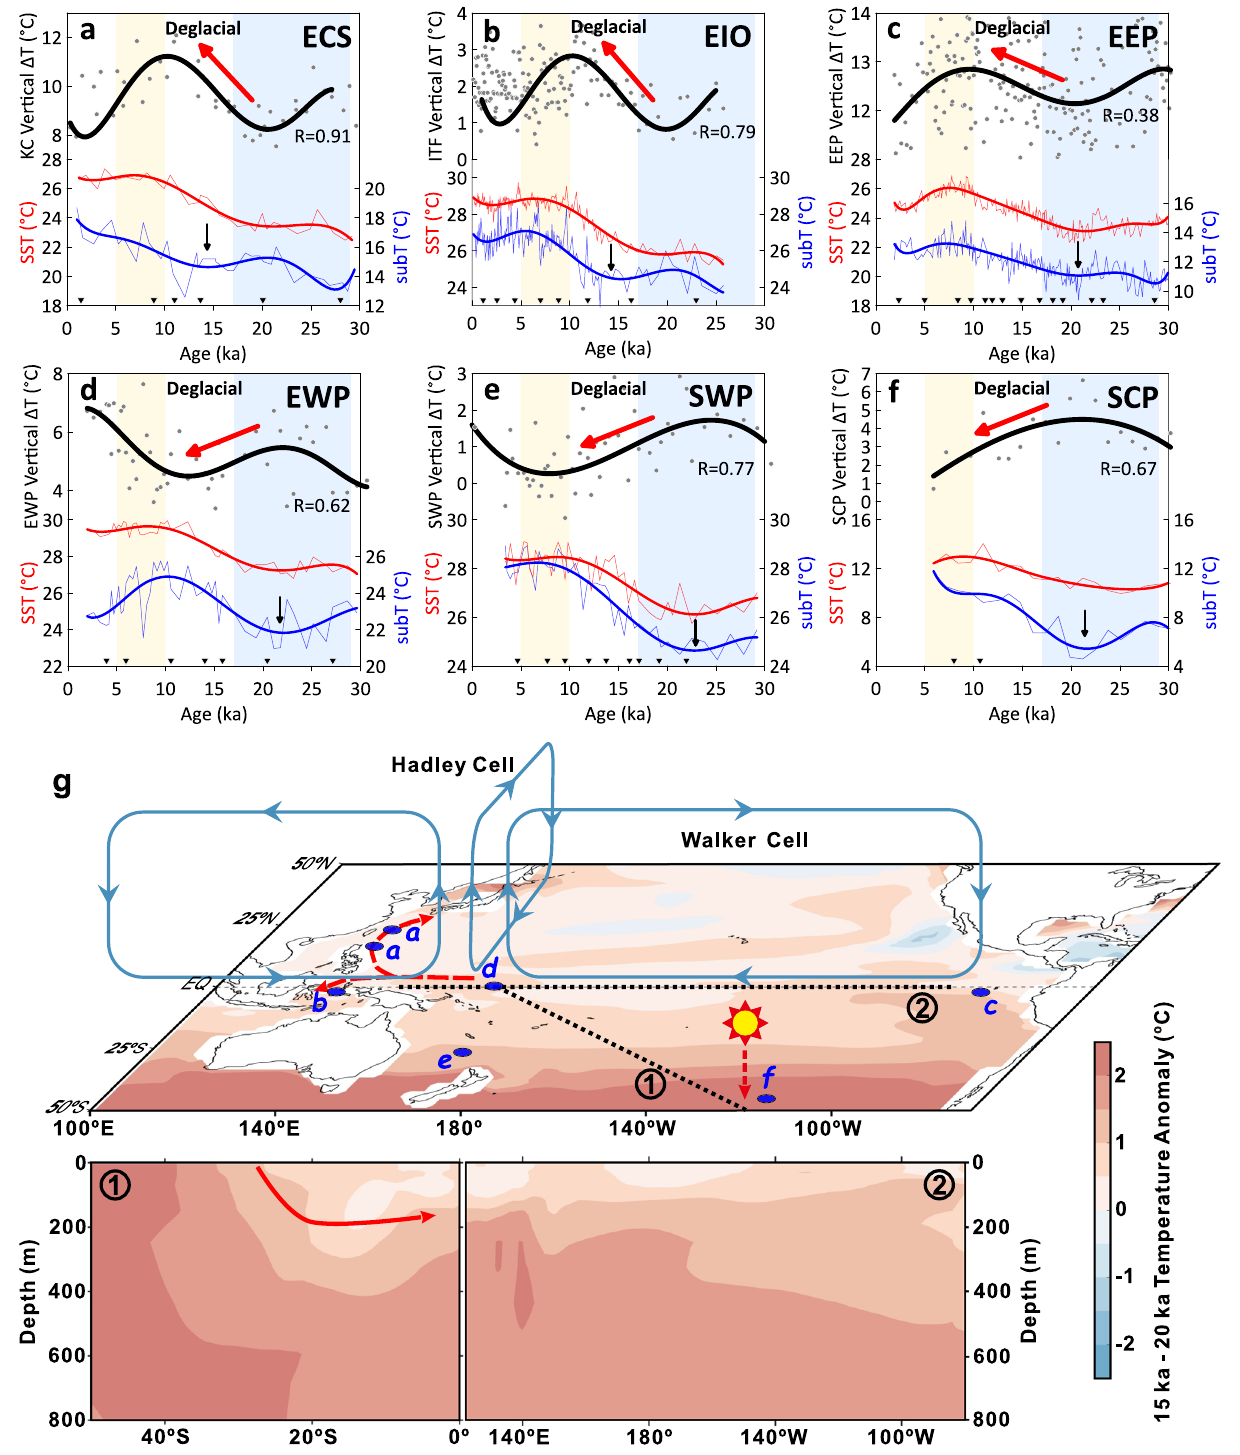
Fig.4 |HypothesizedspatialheattransferprocessinthePaci fi cduringthelast deglaciation. a – f Variations of sea surface temperature (SST), subsurface tem- perature (subT) and their vertical gradient since 30ka along the path of the Kur- oshioCurrent(KC)intheEastChinaSea(ECS) 17,86 ,alongthepathoftheIndonesian Through fl ow(mirrorthevariationintheeasternIndianOcean:EIO) 63 ,intheeastern equatorialPaci fi c(EEP) 64 ,intheeastpartofwesternPaci fi cwarmpool(EWP),inthe southwest Paci fi c (SWP) 87 – 89 and south-central Paci fi c (SCP), respectively, asshown onthemap. g Theboldseasurfacetemperature,subsurfacetemperatureandtheir temperature difference ( Δ T ) lines are polynomial fi tting results for the raw data